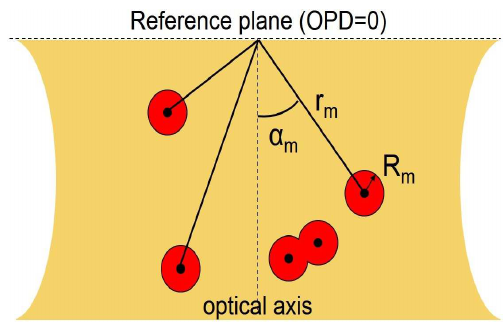
Figure 1. Schematic illustration of an